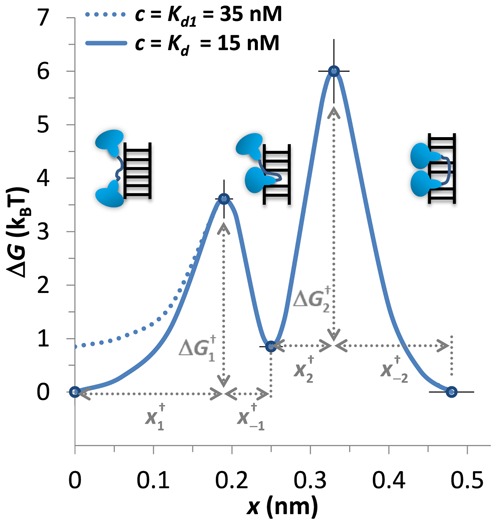
Zero-force free energy profile of the DNA/flex-Ru2 complex versus elongation. The three free-energy minima on this diagram correspond to the non-intercalated, mono-intercalated and bis-intercalated states illustrated in the figure. At the flex-Ru2 concentration of C = Kd = 15 nM, the free energy of the non-intercalated and bis-intercalated states are the same and are taken here as the zero free energy reference state. At higher C = Kd1 = 35 nM the free energies of the non-intercalated and the mono-intercalated states are the same, and equal to kBT.ln(K2) = kBT.ln(35/15) = 0.85 kBT. Only the non-intercalated state free energy is affected by C, as illustrated by the two lines (solid line for 15 nM and dashed line for 35 nM). The free energy barriers \documentclass[12pt]{minimal}
\usepackage{amsmath}
\usepackage{wasysym}
\usepackage{amsfonts}
\usepackage{amssymb}
\usepackage{amsbsy}
\usepackage{upgreek}
\usepackage{mathrsfs}
\setlength{\oddsidemargin}{-69pt}
\begin{document}
}{}$\Delta G_{1,2}^\dagger $\end{document} between the local free energy minima were calculated, as discussed in the main text, and all extensions are taken from Table 2.